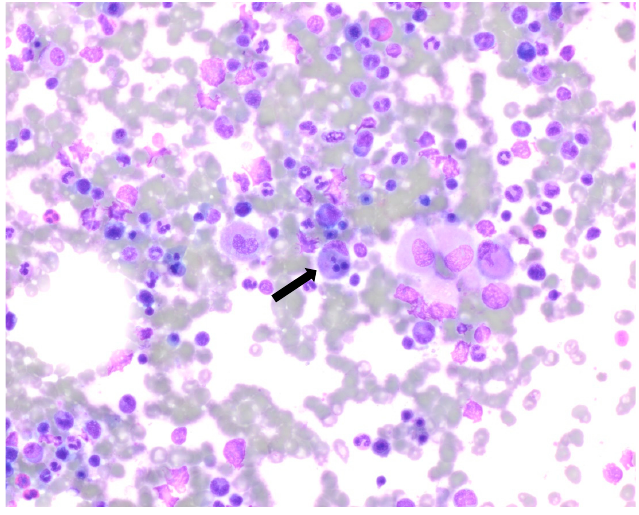
Figure 3. Aspirate smear, the arrow pointing marrow cells engulfed by macrophage. Giemsa stained at 100× oil immersion.